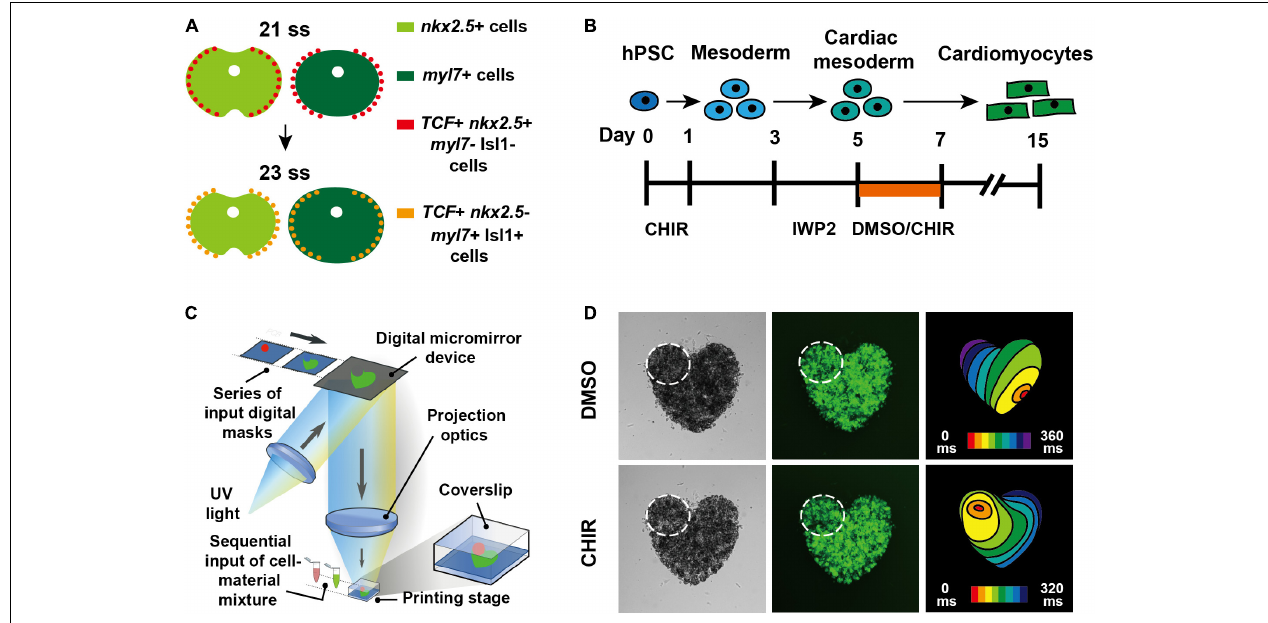
FIGURE 1 | Canonical Wnt signaling promotes pacemaker CM differentiation both in zebrafish and hPSCs (Ren et al., 2019). (A) Schematics illustrate that outlying Nkx2.5 + cardiac progenitor cells respond to canonical Wnt signaling and differentiate into pacemaker CMs in zebrafish. (B) Schematic illustrates the experimental design for inducing pacemaker-like CMs from hPSCs through activating canonical Wnt signaling. (C) Diagram illustrates 3D bioprinting approach. (D) hPSC-derived pacemaker-like CMs can pace other CMs in 3D bioprinted mini heart